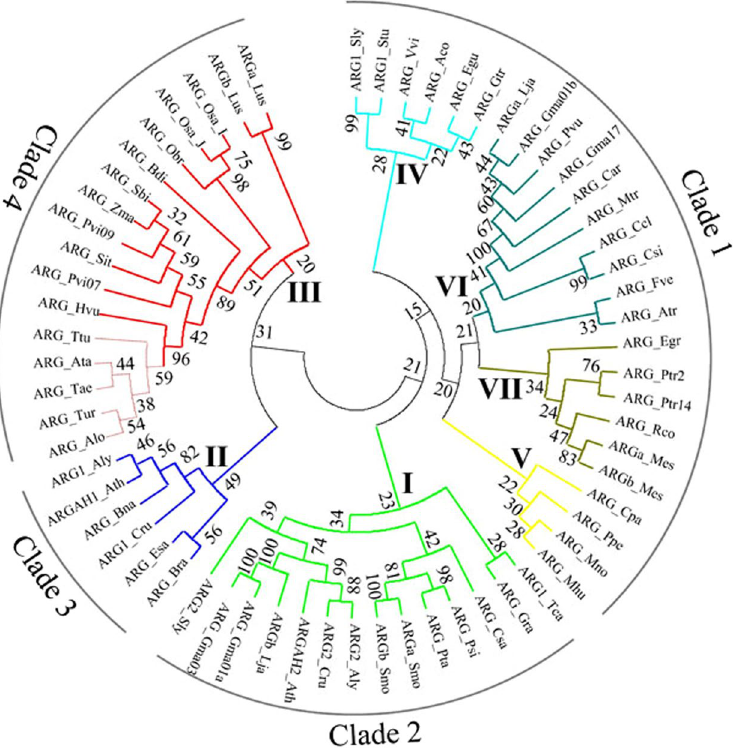
Figure 10. Phylogenetic tree of plant ARG proteins. The cladogram was constructed based on amino acid sequence alignments. The three letters following ARG are abbreviations for plant names in Latin (Additional file 5). The numbers at the nodes indicate the level of confidence for the major branches determined by bootstrap